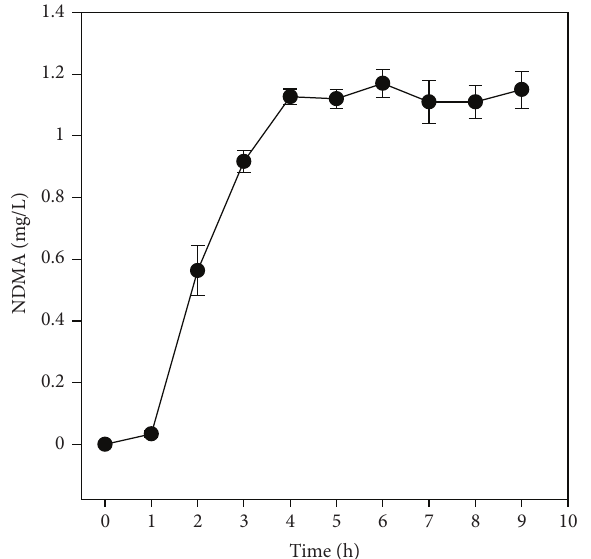
F 1: NDMA formation concentrations in the reaction of 10mM DMA and 4mM NaNO buffer with the reaction time from 1 to 9h. e vertical bars represent the standard deviation (